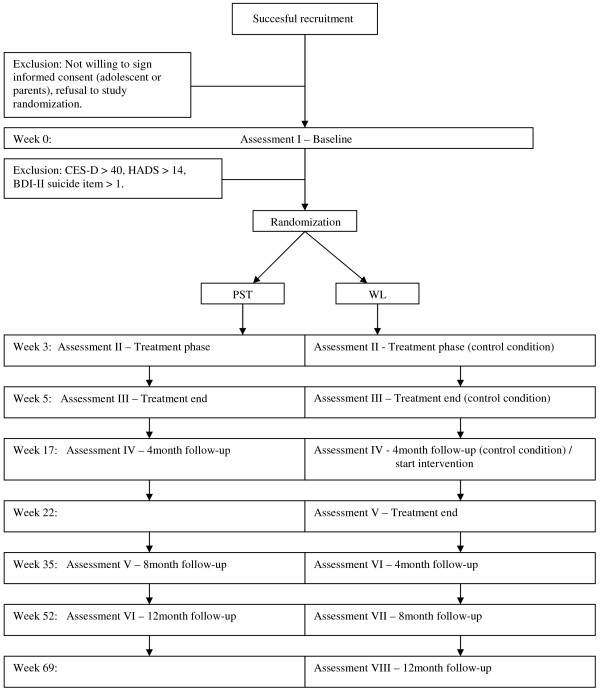
Research procedure.